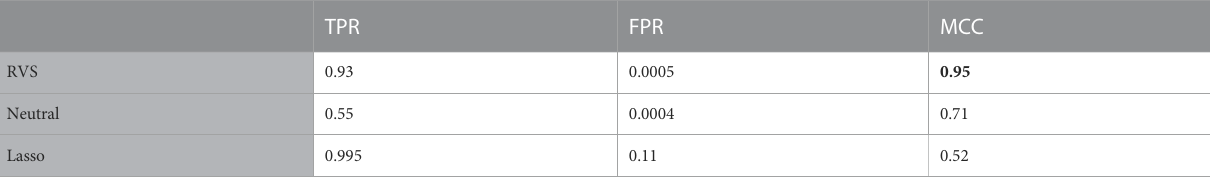
TABLE2Featureselection:Thetruepositiverate(TPR),falsepositiverate(FPR),andMatthew ’ sCorrelationCoef fi cient(MCC)forfeatureselection,forthebalanced simulated data. All metrics are averaged over 100 simulated data sets. The highest MCC value is indicated in